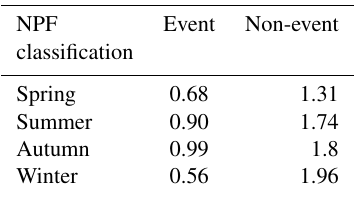
Figure 3. Diurnal cycles of the total ionising capacity pre- sented as medians in different seasons in the years 2003–2006. Table 2. Median radon ionising capacity in cm − 3 s − 1 on new par- ticle formation (NPF) event and non-event days in different seasons over 2003–2006.